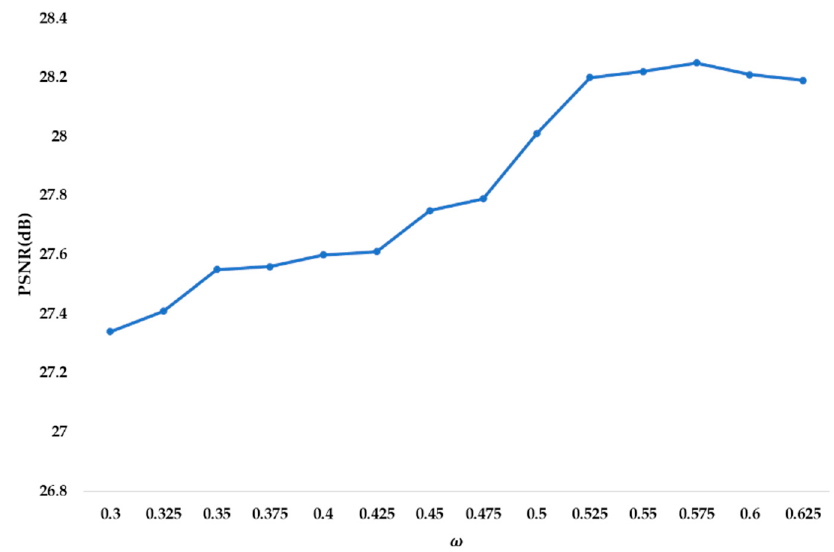
( d ) Figure 7. Comparison of visualization results for gradient estimation. ( a ) test image; ( b ) gradient calculation result of the test image; ( c ) gradient estimation result of the CGI method; ( d ) gradient estimation result of the GEI method. 3.2. Image Interpolation After estimating the gradient of the unknown pixel in the high-resolution image, as mentioned in Section 2, we used the gradient to judge the properties of the unknown pixel and then calculate the pixel value according to the following steps. First, we calculated the gray value I HR (2 i , 2 j ) at position (2 i , 2 j ) in the HR image according to the gray value I LR ( i , j ) at position ( i , j ) in the LR image. Second, I HR (2 i − 1, 2 j ) and I HR (2 i , 2 j − 1) were calculated from I LR ( i , j ) and I HR (2 i , 2 j ), respectively. We adopted this order of calculation because the calculation of I HR (2 i − 1, 2 j ) and I HR (2 i , 2 j − 1) requires I LR ( i , j ) and I HR (2 i , 2 j ). Finally, each non-edge pixel was interpolated using bicubic interpolation. For edge pixels, we used Equation (11) for interpolation [20]. 𝐼 = 𝜔(𝐼